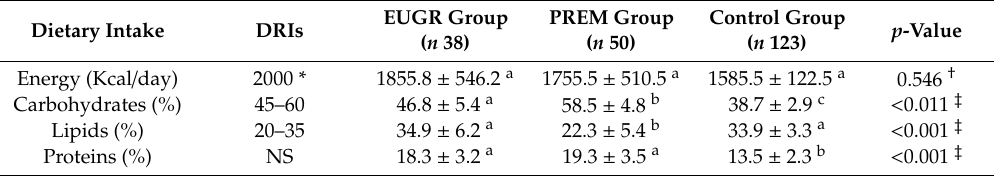
Table 3. Energy and macronutrients intake (% of energy) in prepubertal children with a history of extrauterine growth restriction (EUGR group), those without EUGR (PREM group) and healthy children